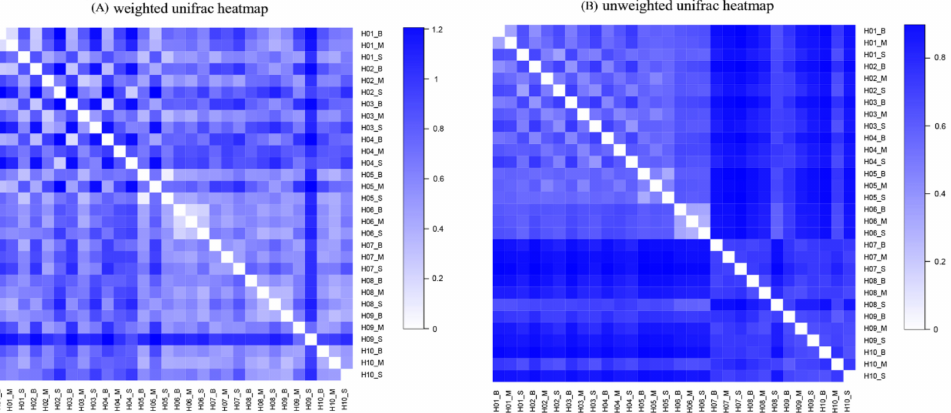
Figure 6. Heatmap-based distance matrix of beta diversity analysis using weighted UniFrac ( A ) and unweighted UniFrac ( B ). In summary, the results reveal that the microbial community profiles relatively differed and eukaryotic plankton communities could be significantly affected by different